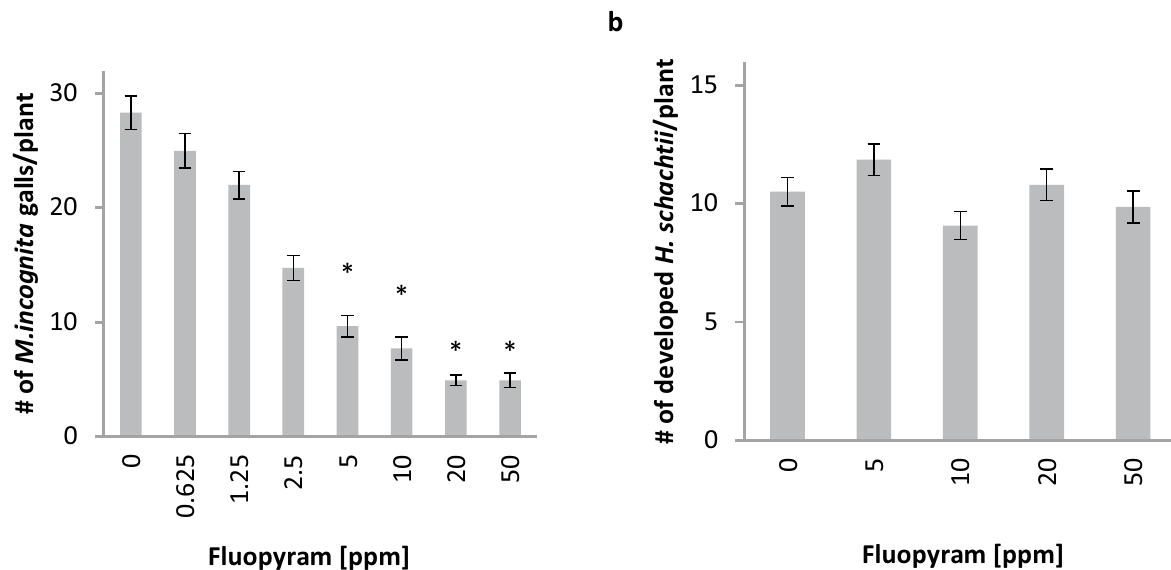
Figure 2. Pre-treatment of J2 with fluopyram reduces Meloidogyne incognita caused gall formation but not Heterodera schachtii infection of host plants. M. incognita J2 ( a ) and H. schachtii J2 ( b ) were incubated in different concentrations of fluopyram or DMSO as control for 48 h. Subsequently, the compound and DMSO were removed, the J2 were incubated in water for further 6 days and then used to inoculate lettuce ( M. incognita ) or Arabidopsis thaliana ( H. schachtii ). The number of galls ( M. incognita ) or the number of males and females ( H. schachtii ) was determined. Bars display mean ± SE of three independent biological replicates (n = 17–18 ( a ); n = 56–60 ( b )). Asterisks indicate significant differences to control according to Dunn’s method ( p <